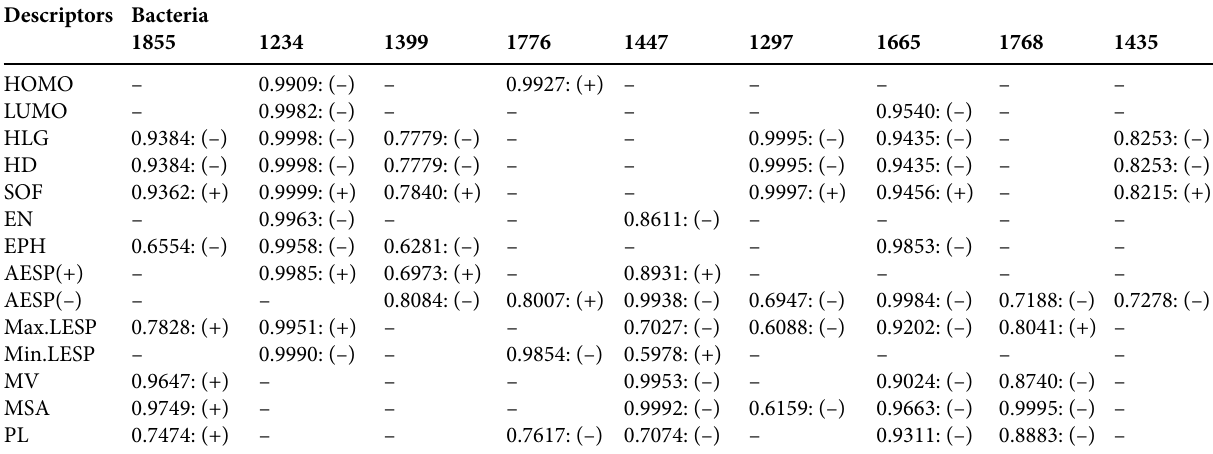
Table 5. The correlation coefficient ( r 2 ) and rate of change sign (+) or (–) of QSAR calculations.